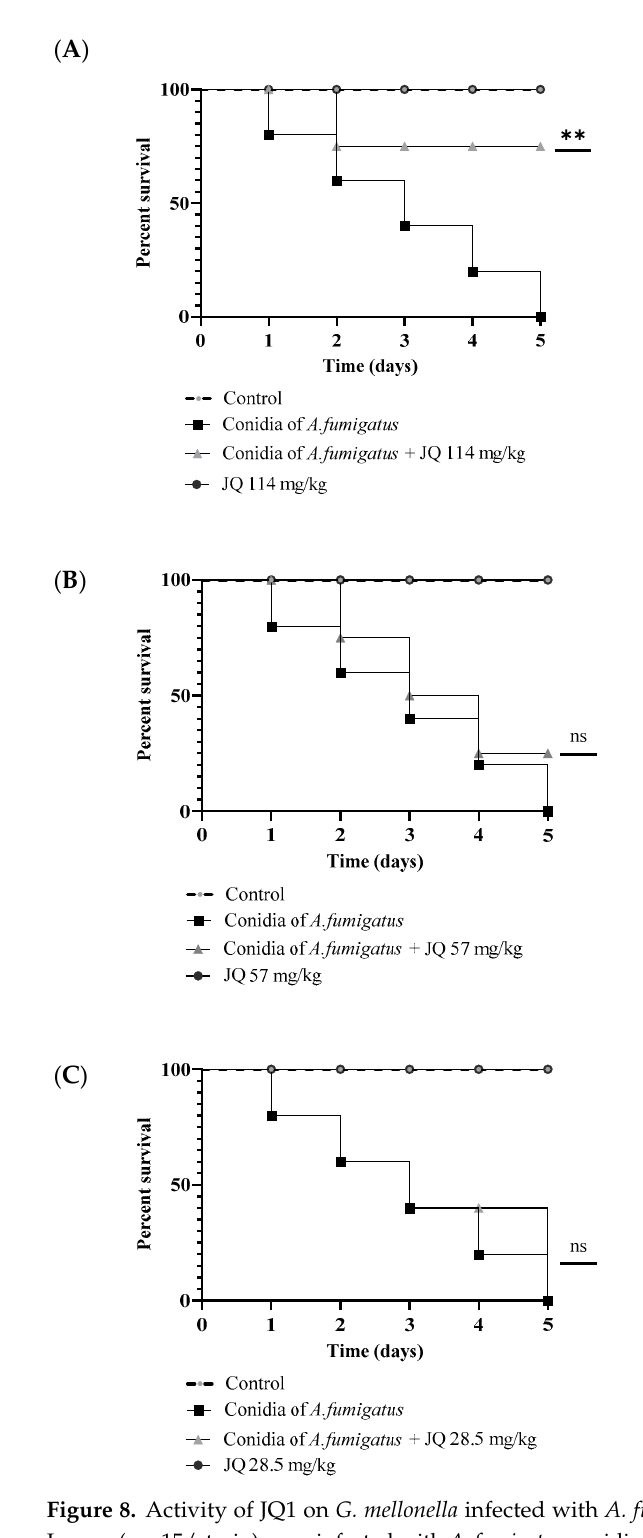
Figure 8. Activity of JQ1 on G. mellonella infected with A. fumigatus . G. mellonella survival curves. Larvae (n = 15/strain) were infected with A. fumigatus conidia (5 × 10 4 conidia/larvae) and monitored daily for 5 days post-infection. JQ1 concentration 114 mg/kg ( A ), JQ1 concentration 57 mg/kg ( B ), JQ1 concentration 28.5 mg/kg ( C ). Statistical significance relative to control was assessed by Kaplan– Meier followed by Mantel–Cox log-rank test. Three experiments on different dates were performed. ** p < 0.01 compared to A. fumigatus without JQ1. 3.10. Pretreatment of A. fumigatus with JQ1 Reduces the Mortality in G. mellonella Model